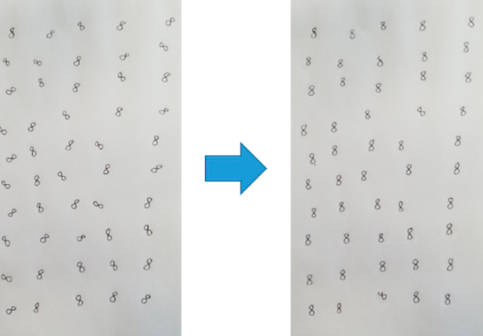
Figure 21. Tilt correction examples of “8” following the proposal ( left : original, right : tilt correction results).